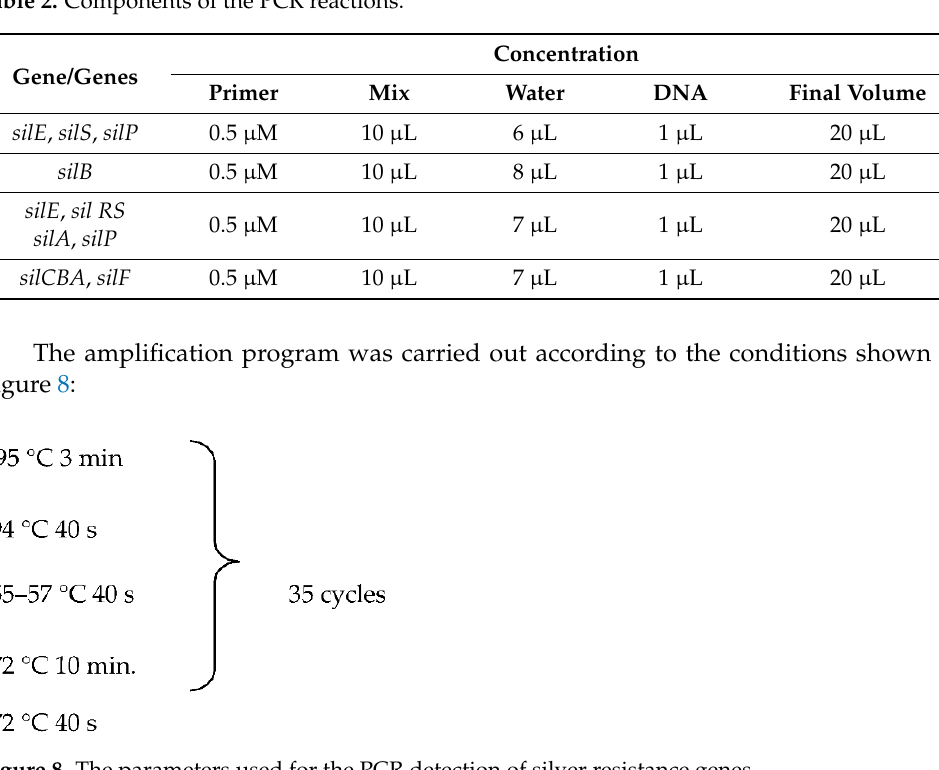
Figure 8. The parameters used for the PCR detection of silver resistance genes.